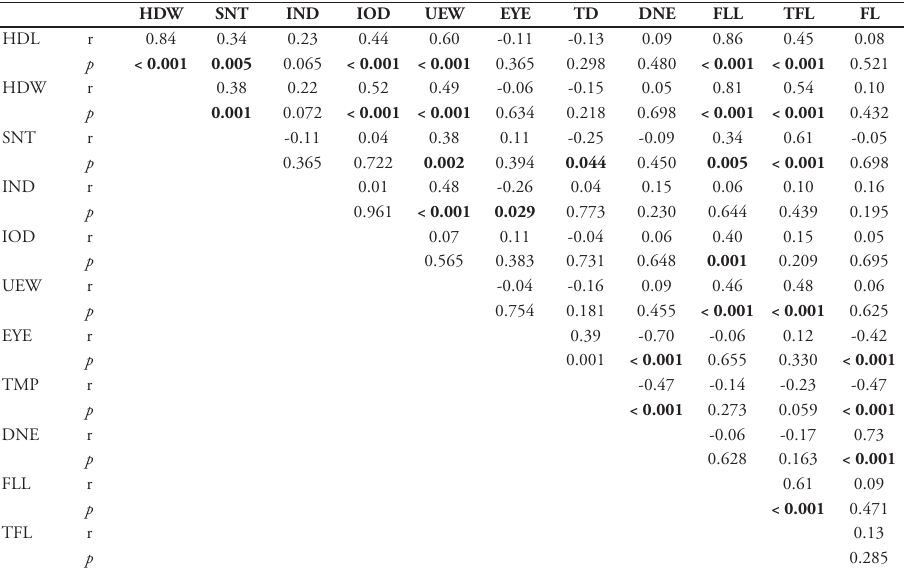
Table 2. Pearson correlation for all ten selected variables. We run a Pearson Correlation test ( n = 68) to highlight the correlation between variables and highlight the need for a variable reduction analysis, such as a PCA. Cells in bold highlight